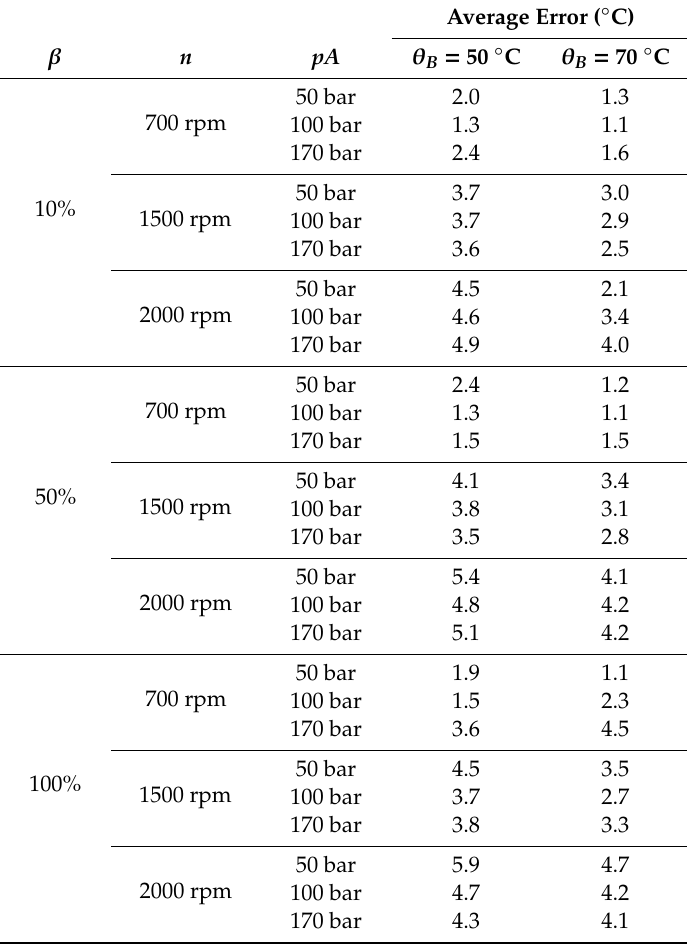
Table 4. Average error of the valve plate